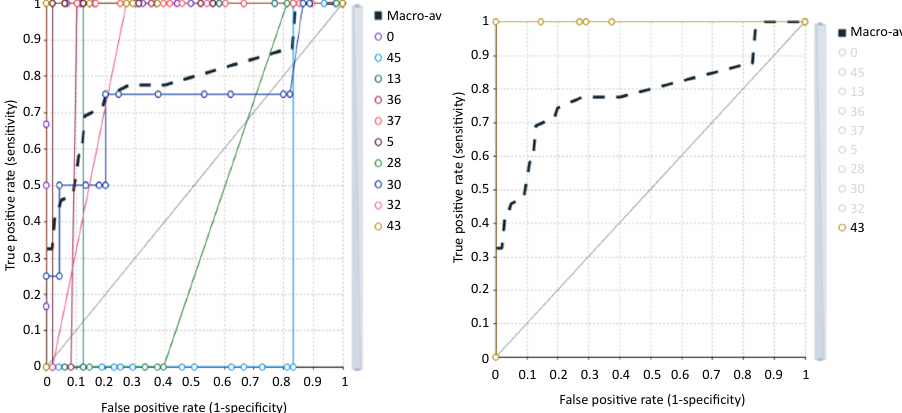
Figure 22. More classes (entire speed range) with precision 0.347 ( left ) and speed 43 km/h with precission 0.980 ( right